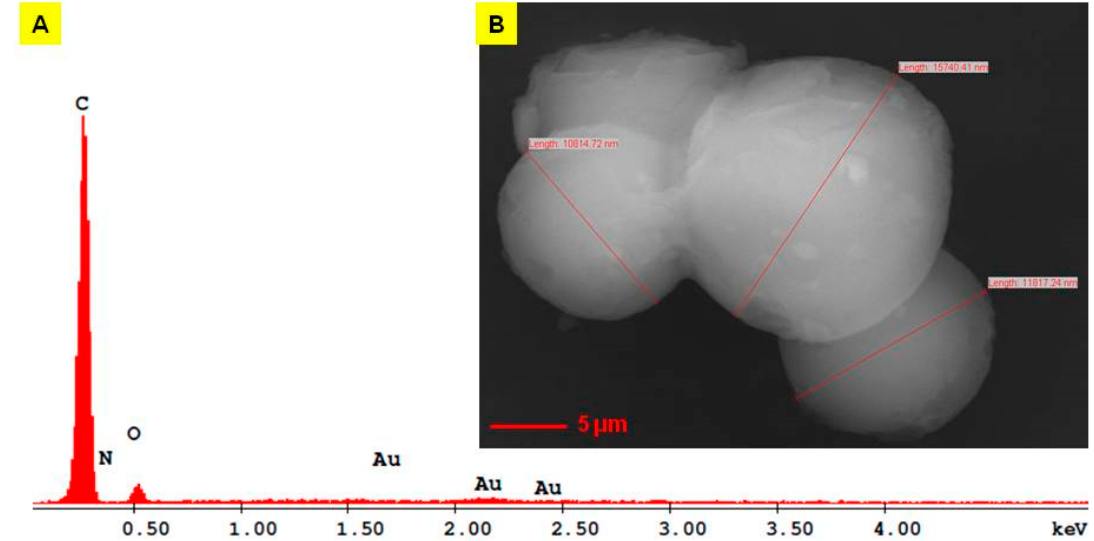
Figure 2. Energy dispersive X-ray spectra ( A ) and scanning electron microscope (SEM) image of EM2 ( B ) [29].